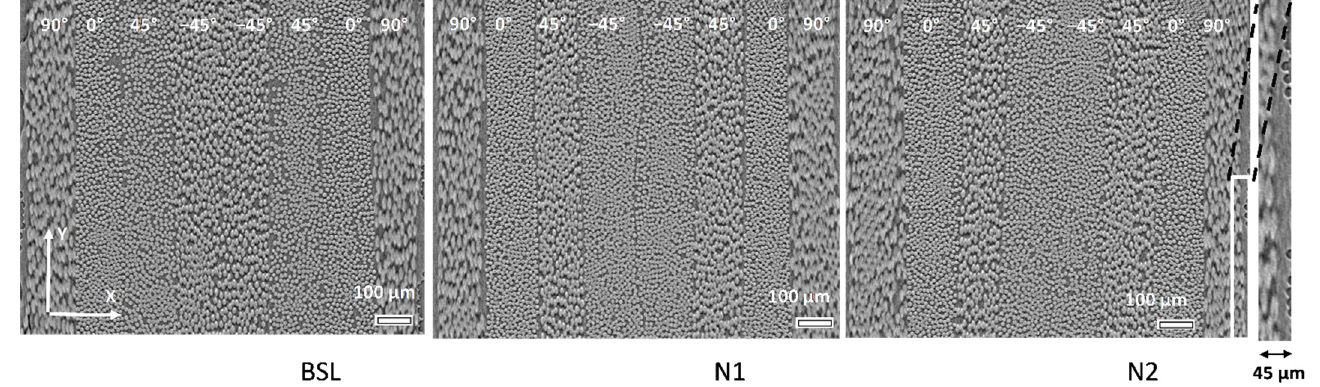
Figure 2. Images of the laminates: XY slices, slice # 1000 for all of the images. Nominal ply angles are shown. Right: close ‐ up on the film region on the surface of the laminate.